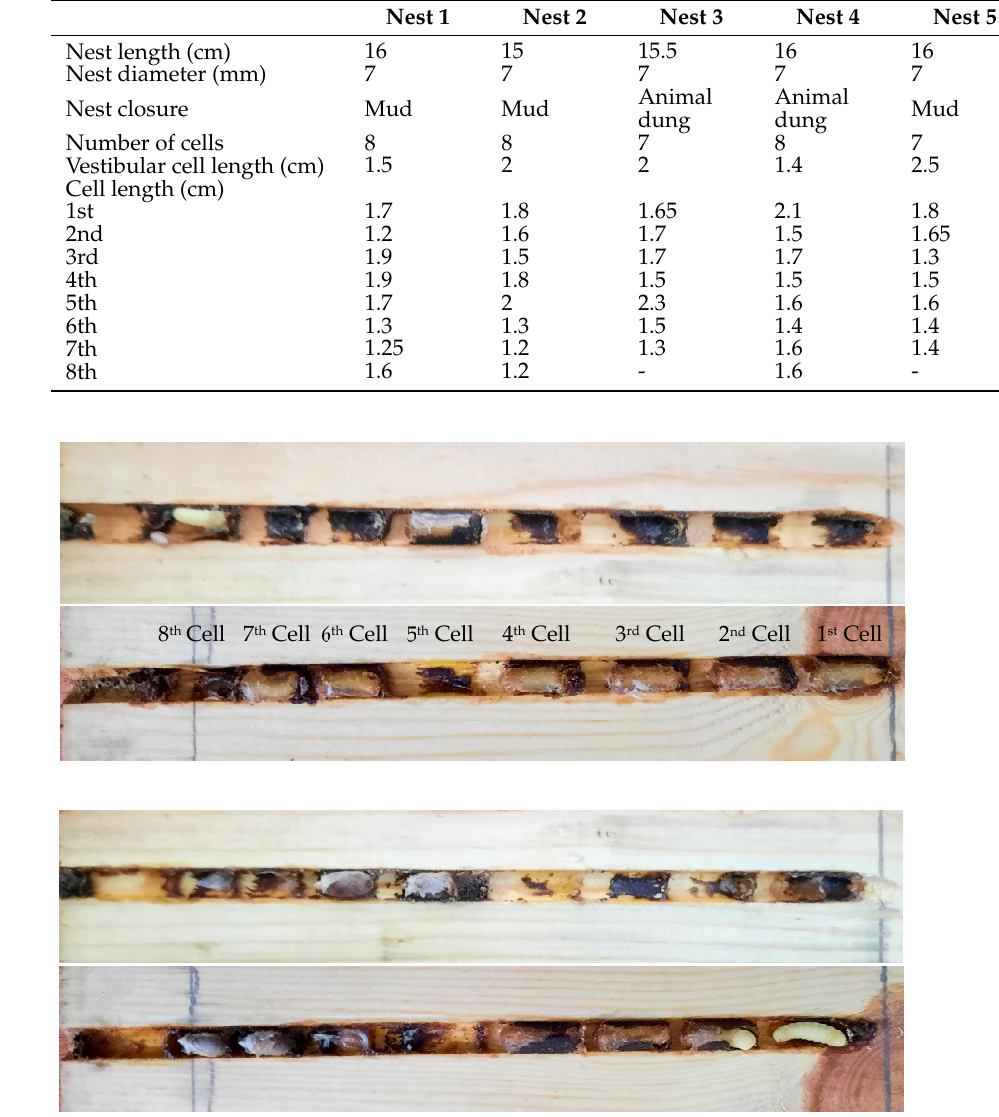
Figure 5. Samples of wooden plates consisted of Megachile cephalotes larval, pre-pupal, and pupal stages.